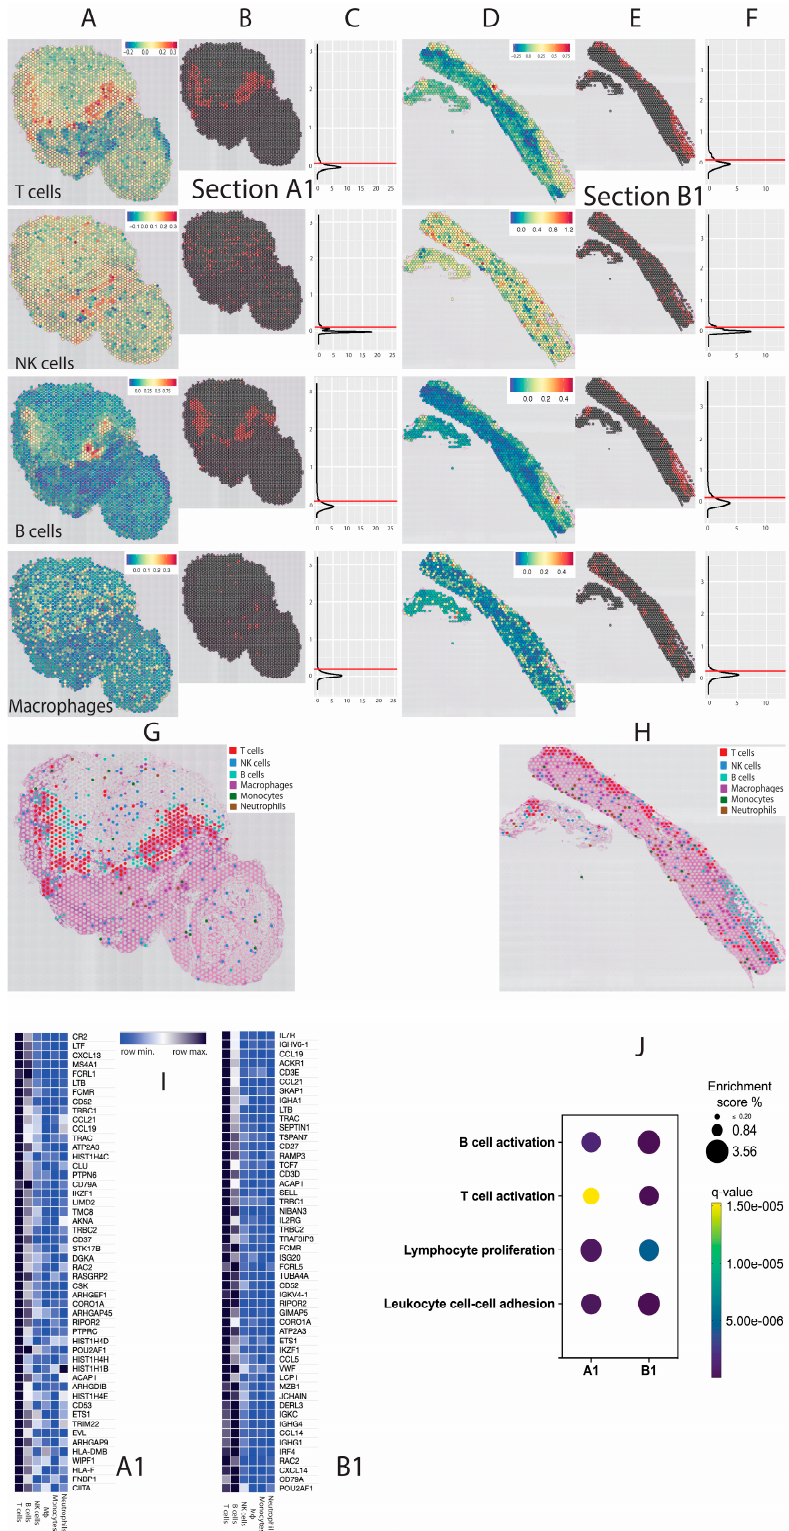
Figure 3 . Identi fi cation of tumour-in fi ltrating immune cells using the ImSig algorithm in tissues A1 Figure 3. Identification of tumour-infiltrating immune cells using the ImSig algorithm in tissues and B1. ( A , D , G , H ) Loupe images demonstrating in fi ltrating immune cells identi fi ed using the ImSig A1 and B1. ( A , D , G , H ) Loupe images demonstrating infiltrating immune cells identified using the ImSig algorithm in tissue A1 and B1 respectively. ( B , E ) R images representing the selection of custom cut-off values for each type of immune cell(s). ( C , F ) Histograms represent the cut-off values